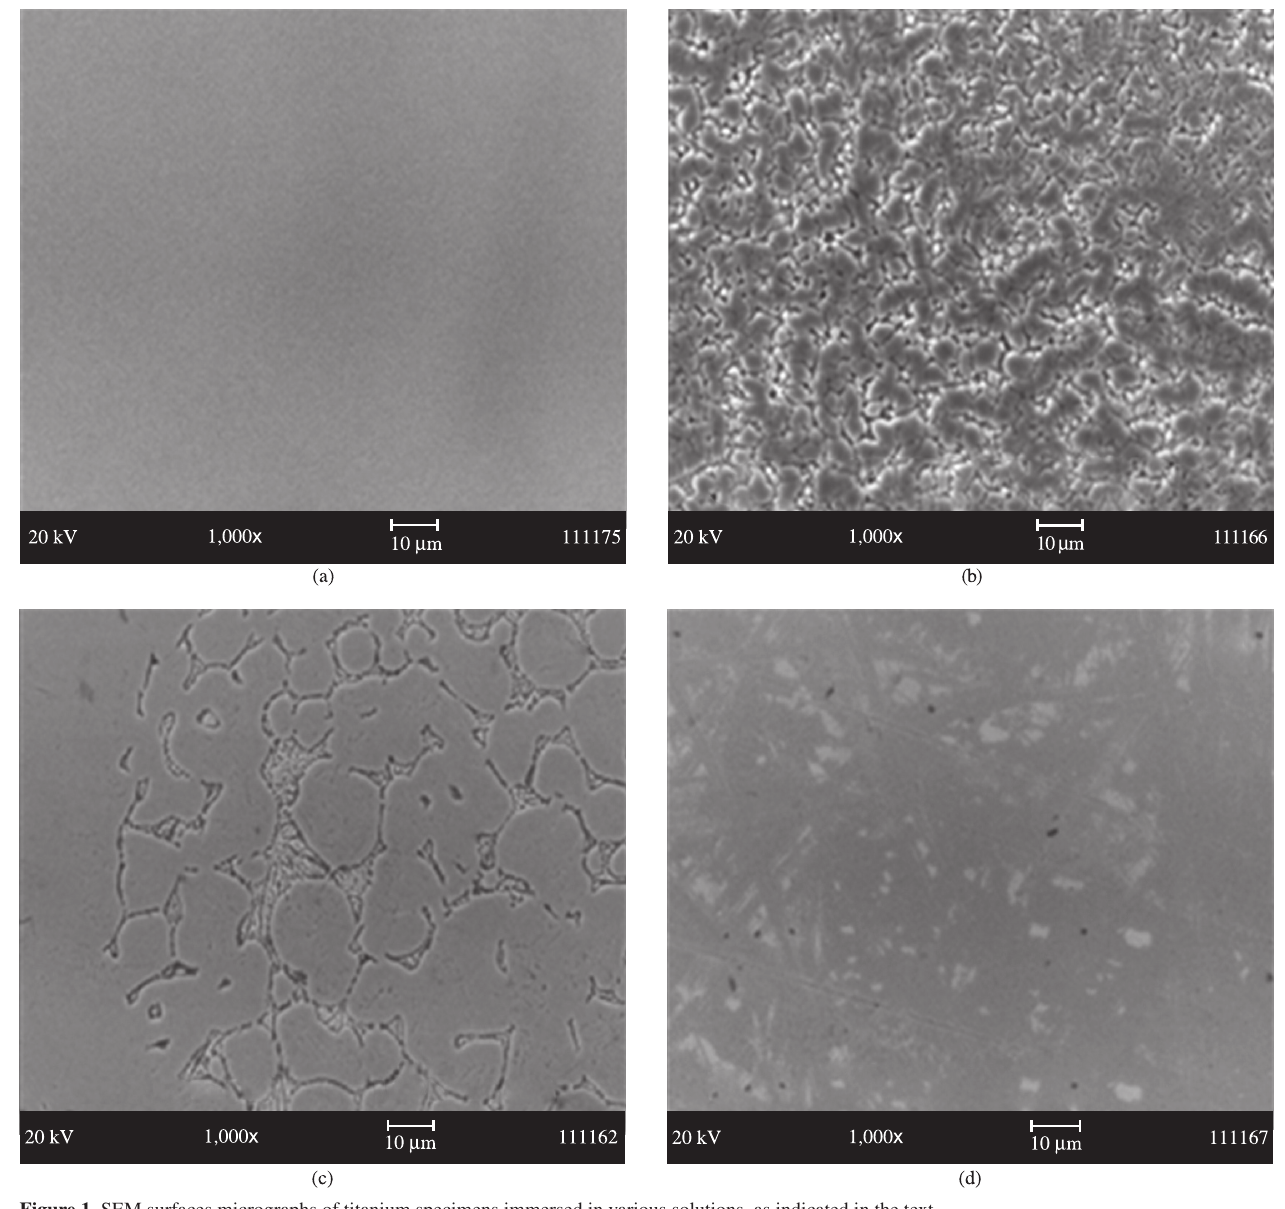
Figure 1. SEM surfaces micrographs of titanium specimens immersed in various solutions, as indicated in the